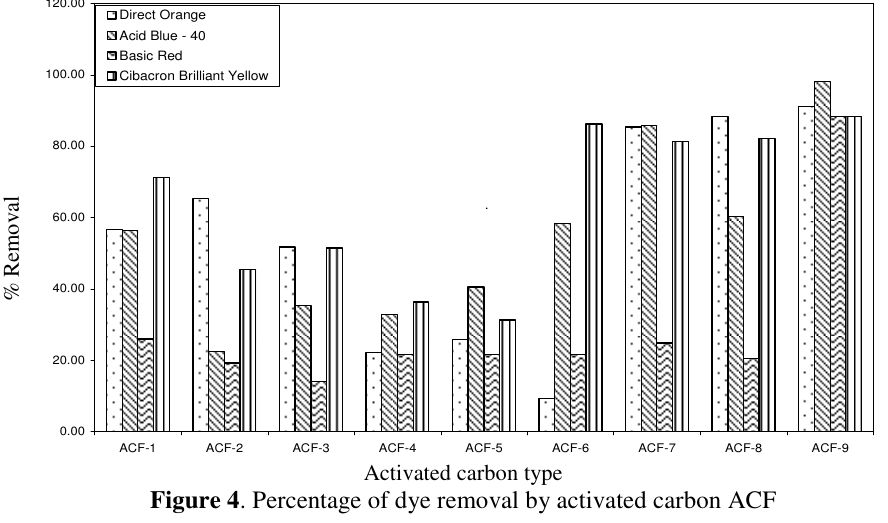
Figure 4 . Percentage of dye removal by activated carbon ACF